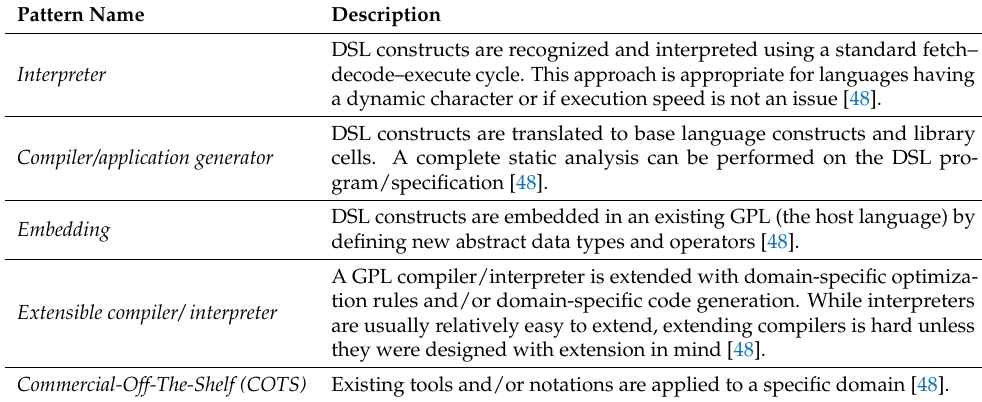
Table 8. Implementation phase patterns considered during the implementation